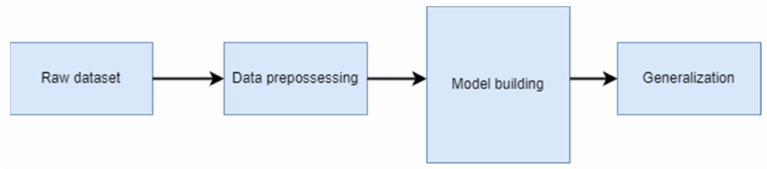
Figure 3. A typical machine learning process.